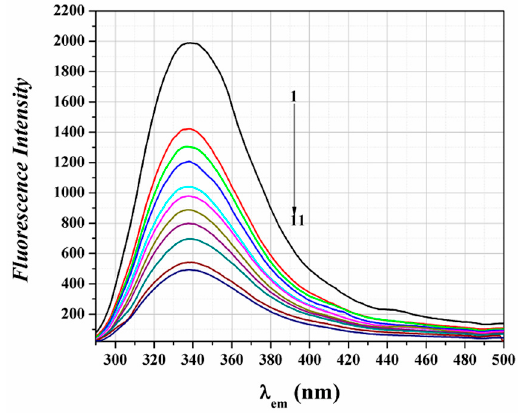
Figure 3. Emission spectra of ( 1 ) BSA (1.5 μ M) and the BSA-compound 3 system succeeding the addition of compound 3 at the concentrations of ( 2 ) 0.65 μ M; ( 3 ) 1.0 μ M; ( 4 ) 1.5 μ M; ( 5 ) 3.0 μ M; ( 6 ) 4.5 M; ( 7 ) 6.0 μ M; ( 8 ) 9.0 μ M; ( 9 ) 12.0 μ M; ( 10 ) 18 μ M; ( 11 ) 25 μ M.